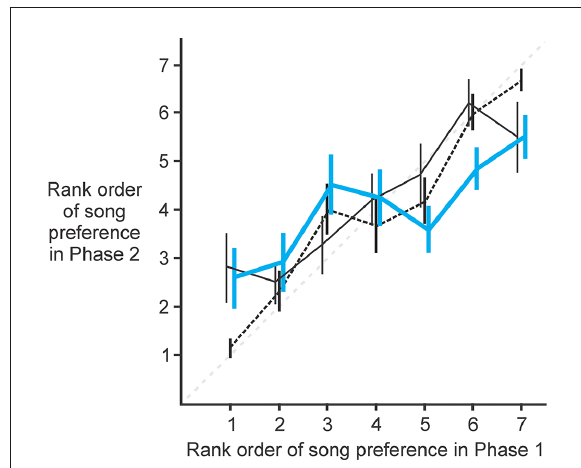
FIGURE5 NC lesioned females were unchanged in their rank ordering of song preferences. Data from experimental (thick blue solid line; paired t-test, t = 0.10, p = 0.92), control (thin black solid line; paired t-test, t = 0.48, p = 0.48), and sham birds (thin black dashed line; paired t-test, t = 0.00, p = 1.00) all revealed no significant change in rank ordering of preference from Phase 1 to Phase 2 of behavioral testing (thin gray dashed line indicates the line of identity representing no change in rank ordering from Phase 1 to Phase 2).